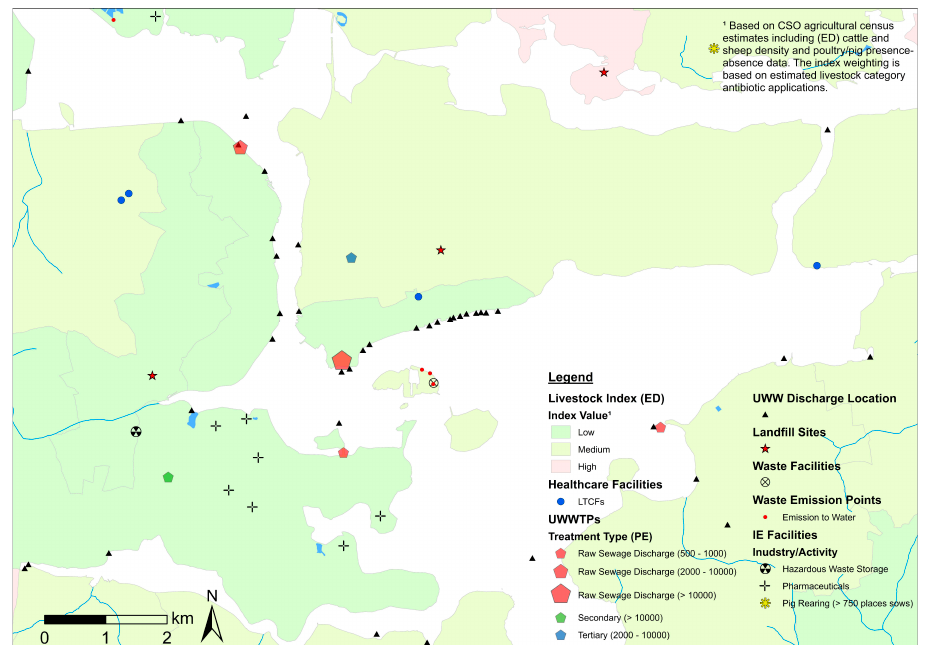
Figure 5. High resolution (fine-scale) map of potential ARO sources (classified) and healthcare facilities in Cork Harbour with livestock index estimates. Notes: Livestock index estimates are included as a base map layer. ED = electoral district. UWWTPs = urban wastewater treatment plants. UWW = urban wastewater. IE = industrial emissions. PE = population equivalent (i.e., estimated population served by UWWTPs).